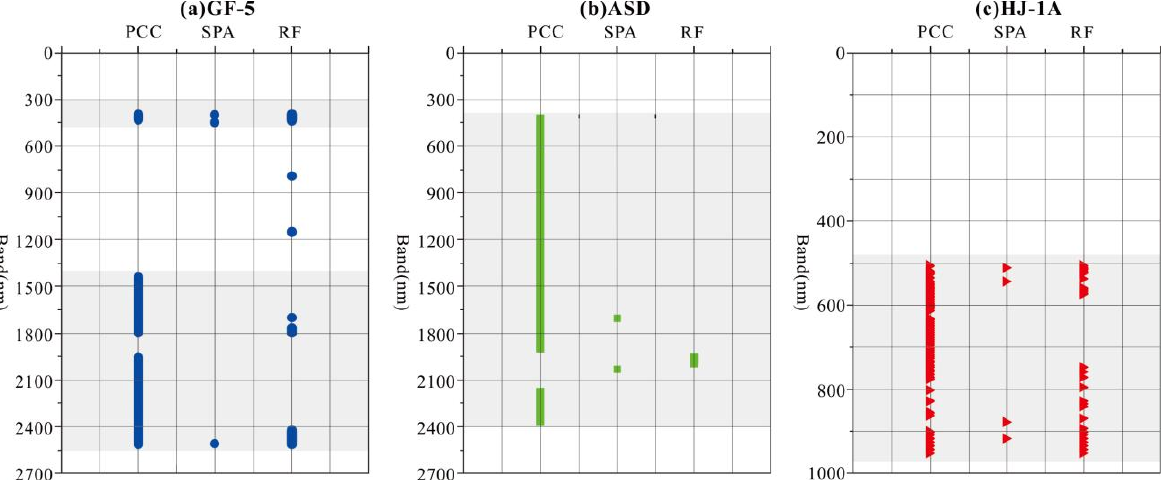
Figure 7. The screened bands of three band screening methods (PCC, SPA, and RF) for ( a ) GF-5, ( b ) ASD, and ( c ) HJ-1A spectra. The principal components after PCA processing are linear combinations of the original variables, so PCA was not shown in the figure.